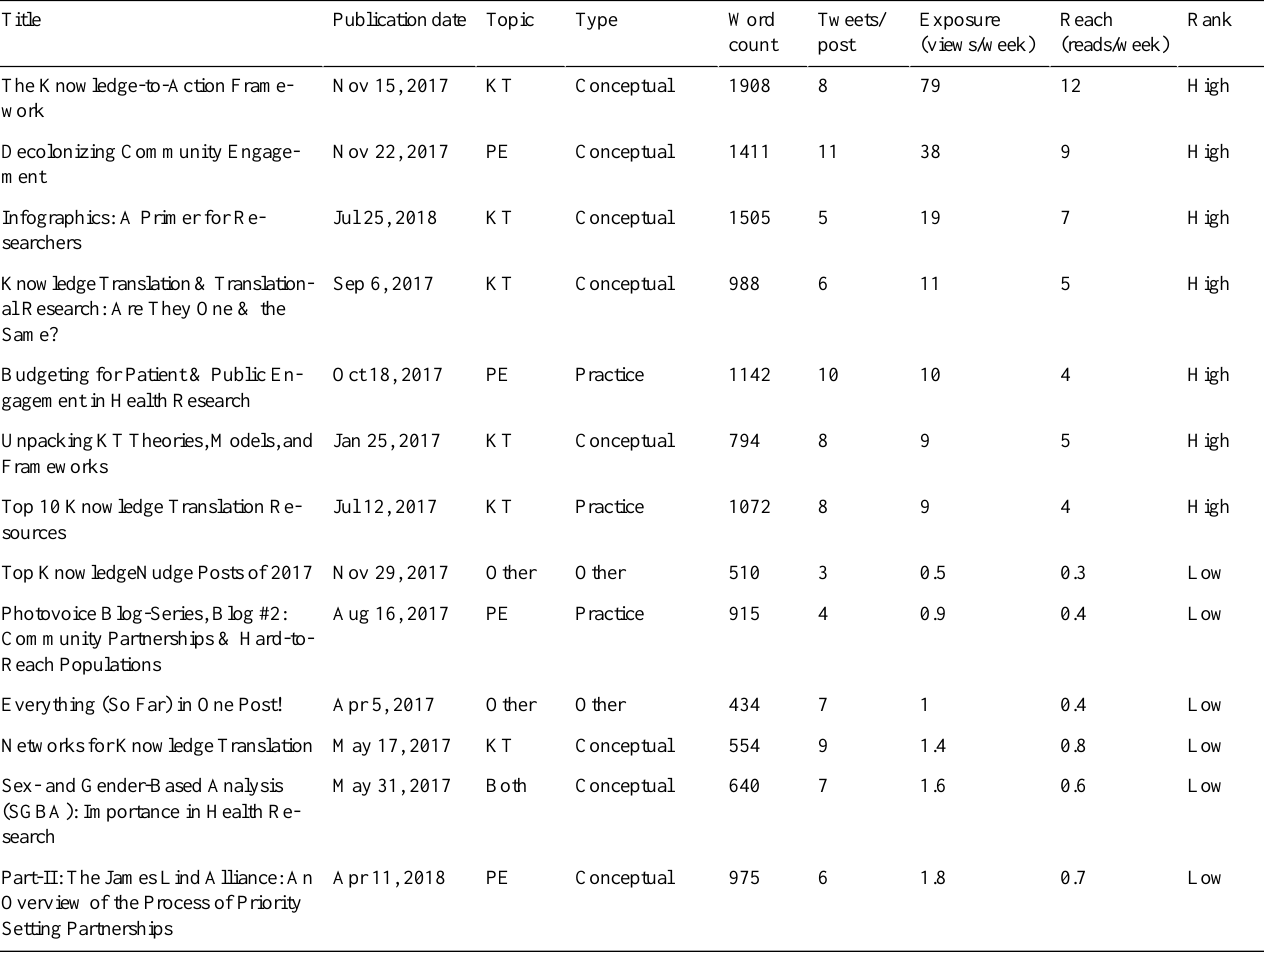
Table 1. Characteristics of high- and low-profile KnowledgeNudge posts (those within the highest and lowest 10th percentile for both exposure and